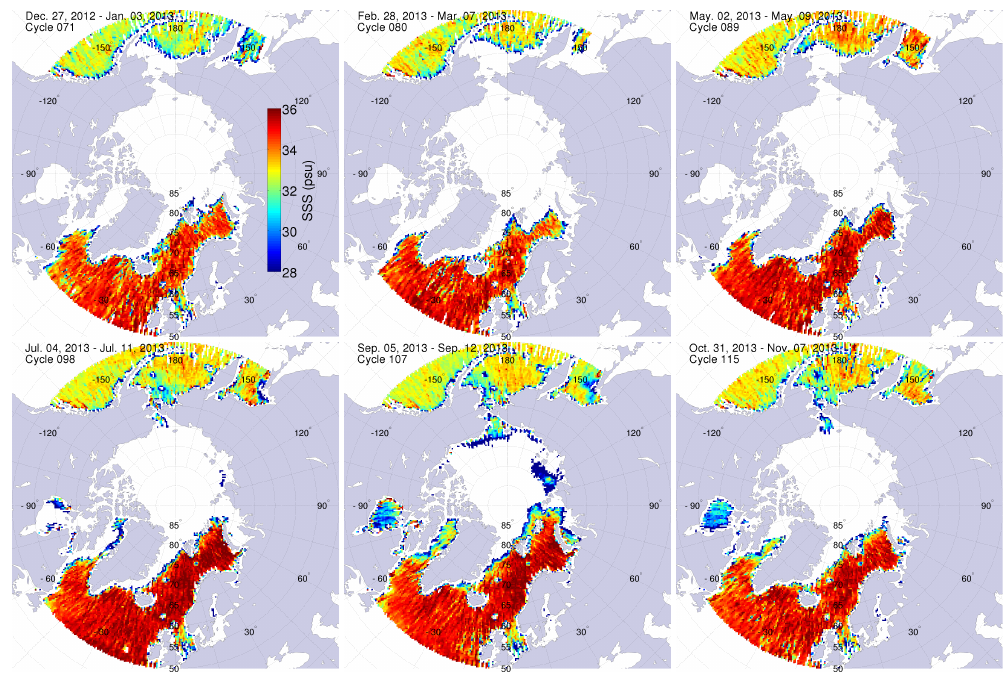
Fig. 17. Maps of SSS3b over the NH high latitudes for cycles every other month in 2013. Grid cells where the land fraction was more than 0.25 were masked.